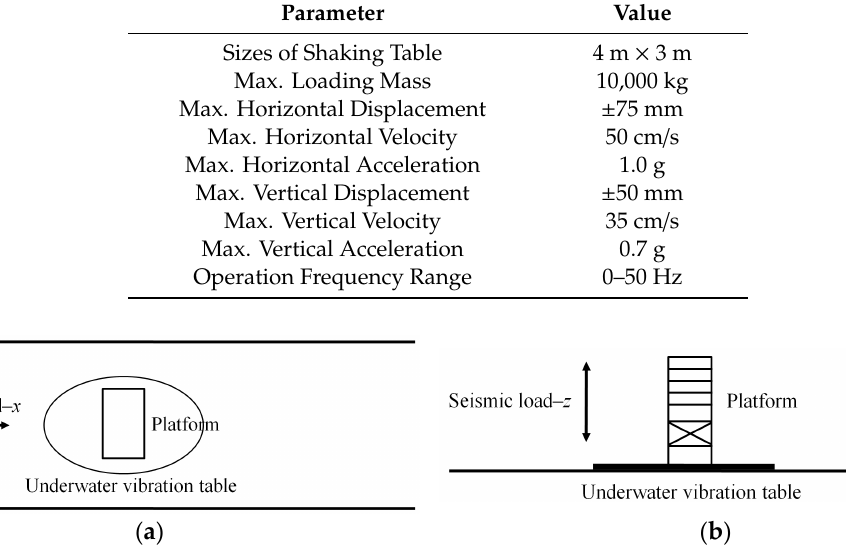
Figure 2. The elliptic underwater vibration table in the flume.